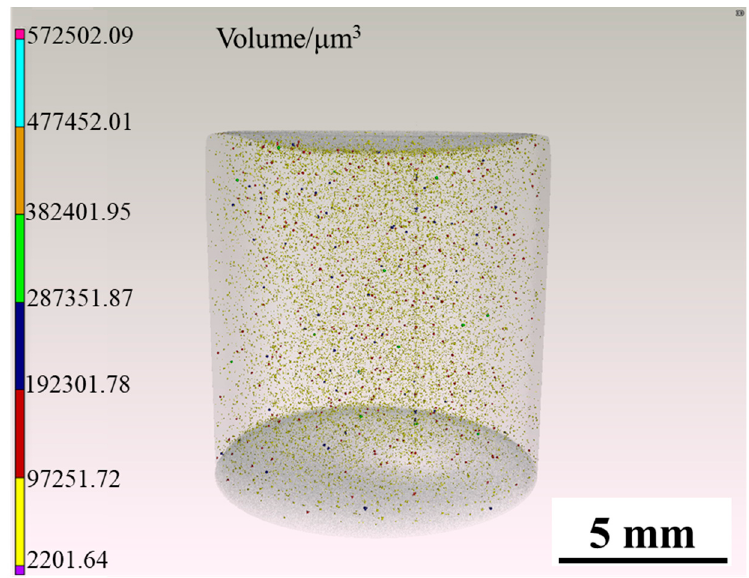
Table 4. The EDS analysis of A3 sample in Figure 12 (wt.%).